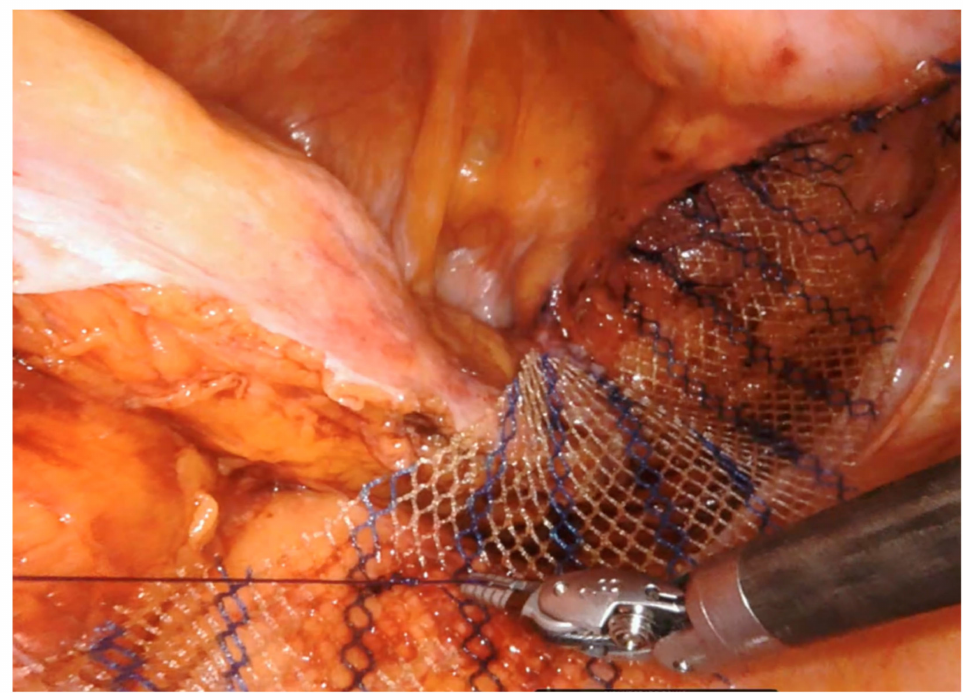
Figure 4. The mesh (macroporous polipropilene) is secured cranially at the level of the sacral promontory with permanent sutures.